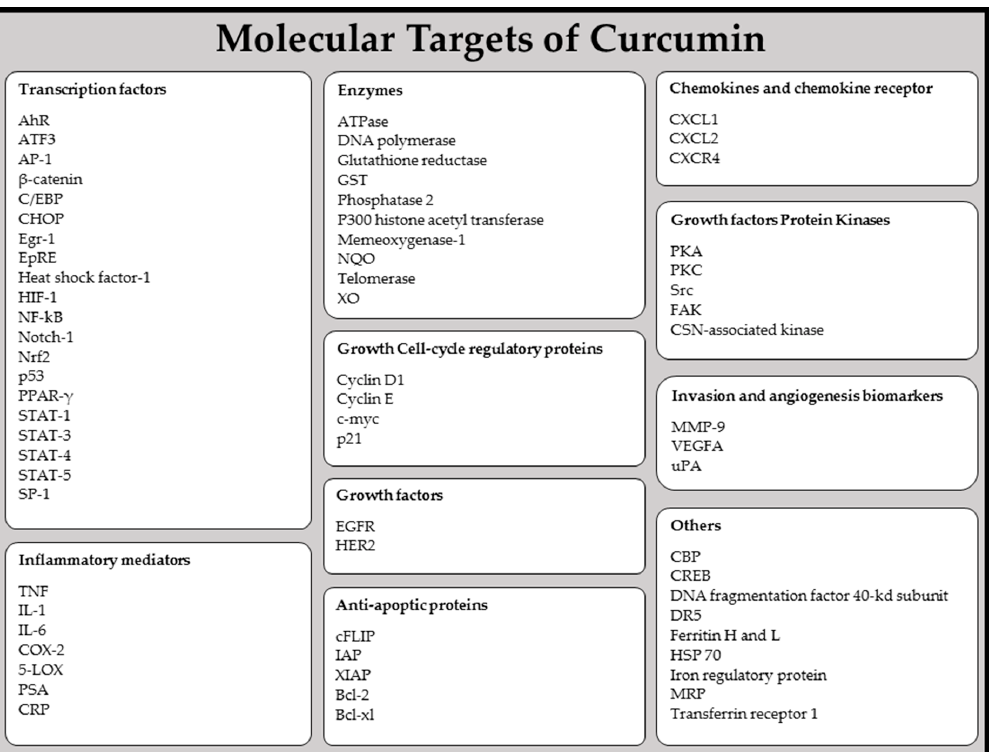
Figure 2. Molecular targets of curcumin. AhR, aryl hydrocarbon receptor; ATF, activating transcription factor; AP, activator protein; CBP, P300/CREB-binding protein; CHOP, C/EBP homologous protein; COP, constitutive photomorphogenic; COX, cyclooxygenase; CREB, cAMP response element binding; CSN, COP9 signalosome; CXCL, chemokine ligand; CXCR chemokine receptor; cFLIP, cellular FLICE-like inhibitory protein; CRP, C-reactive protein; DR, death receptor; EGFR, epidermal growth factor receptor; Egr, Early growth response; EpRE, electrophile response element; FAK, focal adhesion kinase; GST, glutathione S -transferase; HIF, hypoxia inducible factor; HSP, heat-shock protein; IAP, inhibitor of apoptosis protein; IL, interleukin; LOX, lipoxygenase; MMP, matrix metallopeptidase; MRP, multidrug resistance protein; NQO, naphthoquinone oxidoreductase; NADP(H), nicotinamide adenine dinucleotide phosphate (reduced form); Nrf2, NFE2-related factor; NF- κ B, nuclear factor-kappa B; MRP, multi-drug resistance protein; PPAR- γ , peroxisome-proliferator-activated receptor-gamma; PKA, protein kinase A; PKC, protein kinase C; PSA, prostatic specific antigen; STAT, signal transducers and activators of transcription protein; TNF, tumor necrosis factor; uPA, urokinase plaminogen activator; VEGF, vascular endothelial growth factor; XIAP, X-linked IAP, XO, xanthine